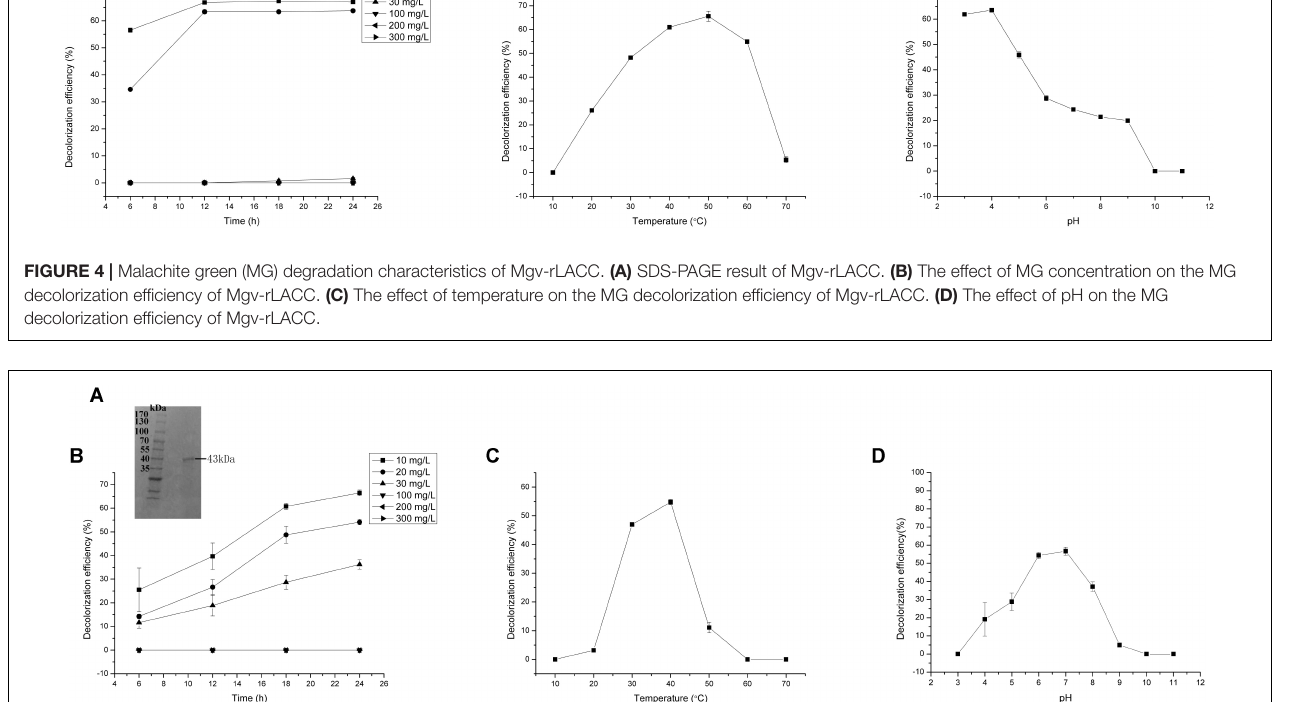
FIGURE 5 | Malachite green (MG) degradation characteristics of Mgv-rCYP. (A) SDS-PAGE result of Mgv-rCYP. (B) The effect of MG concentration on the MG decolorization efficiency of Mgv-rCYP. (C) The effect of temperature on the MG decolorization efficiency of Mgv-rCYP. (D) The effect of pH on the MG decolorization efficiency of Mgv-rCYP.